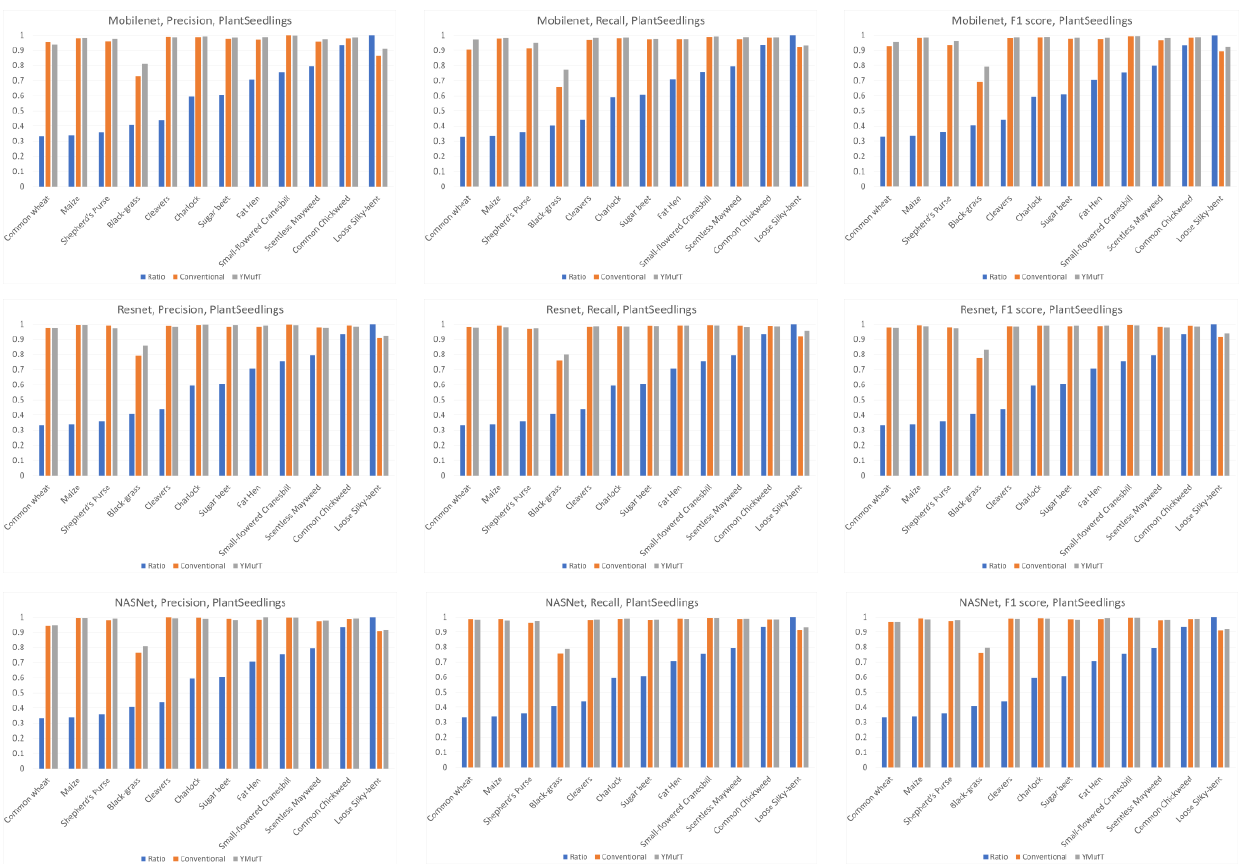
Figure 21. Average overall performance of 5-fold cross-validation on the PlantSeedlings dataset.